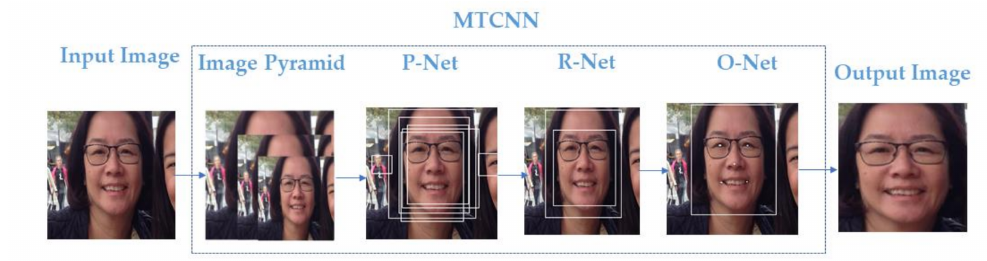
Figure 5. Face detection process over raw face images using